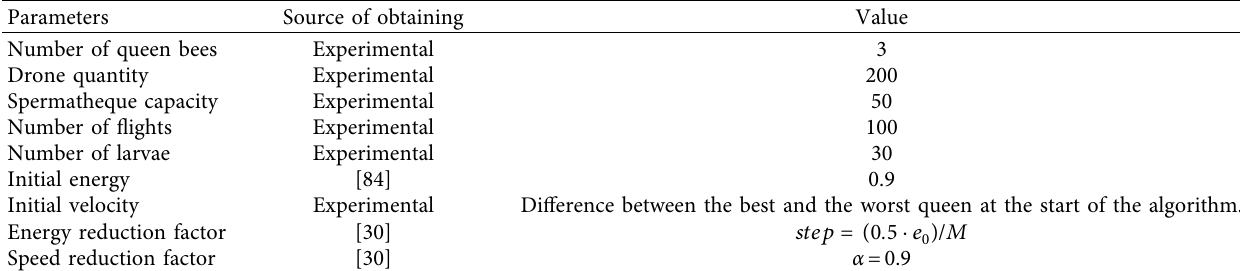
Table 1: Algorithm